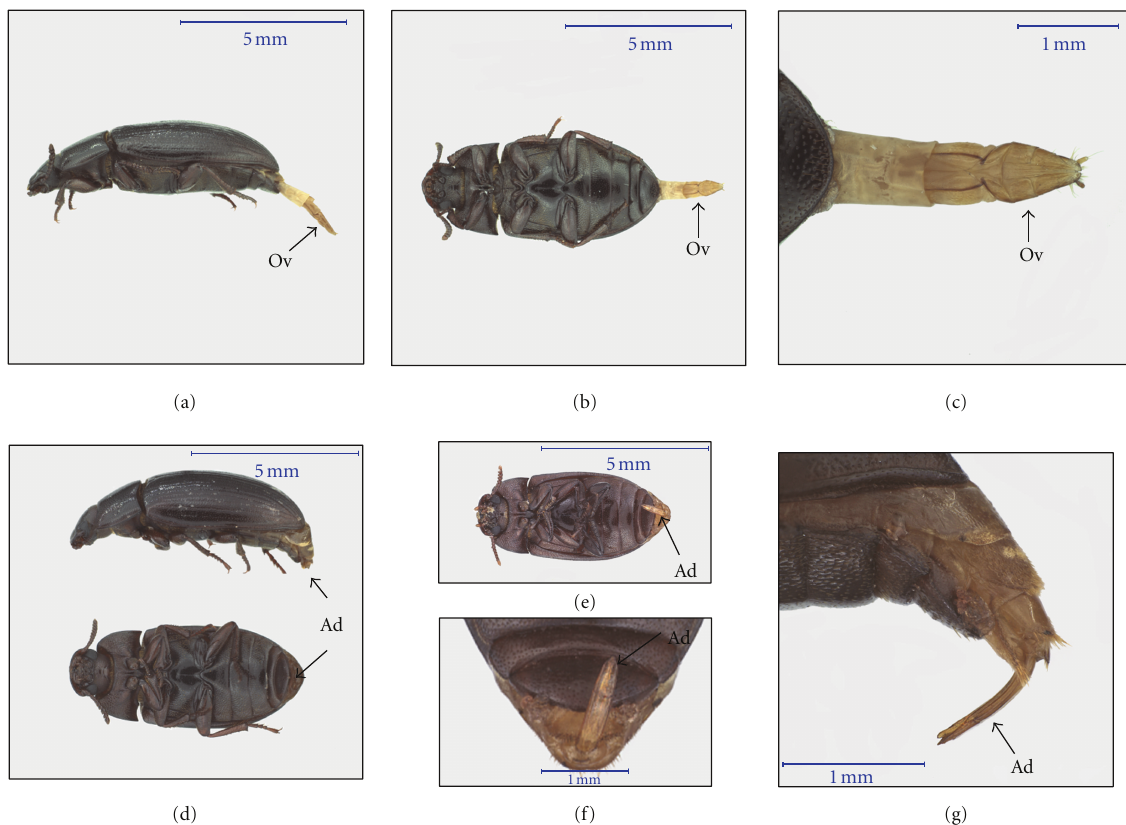
Figure 4: Genitalia of A. diaperinus adults: female ovipositor:protracted, lateral (a), and ventral views (b, c); male aedeagus:retracted, lateral, and ventral views (d); protracted, ventral (e, f), and lateral views (g). Ad, aedeagus; Ov,